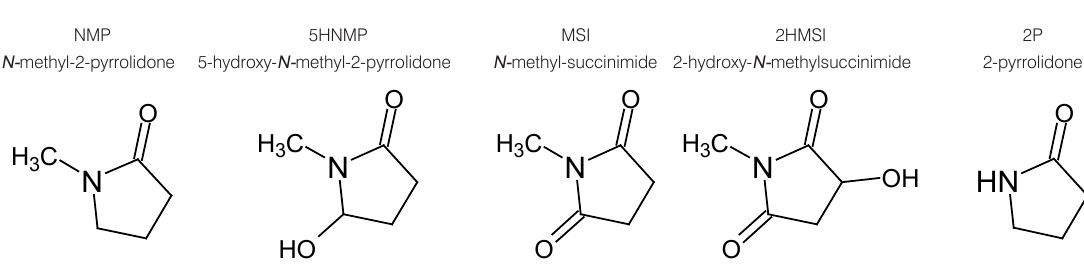
Figure 1. Structures of NMP and its metabolites found in rat and human